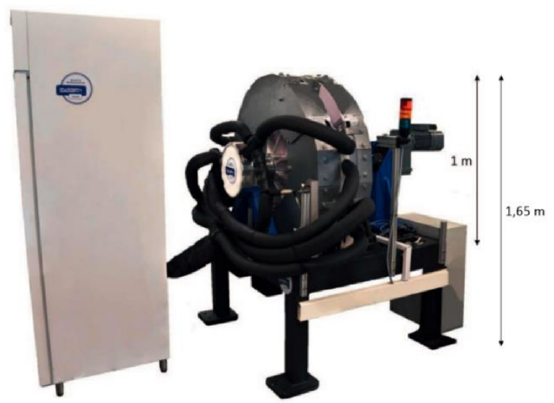
Figure 10. Device, the “BUA” of Chaudron et al. [50].